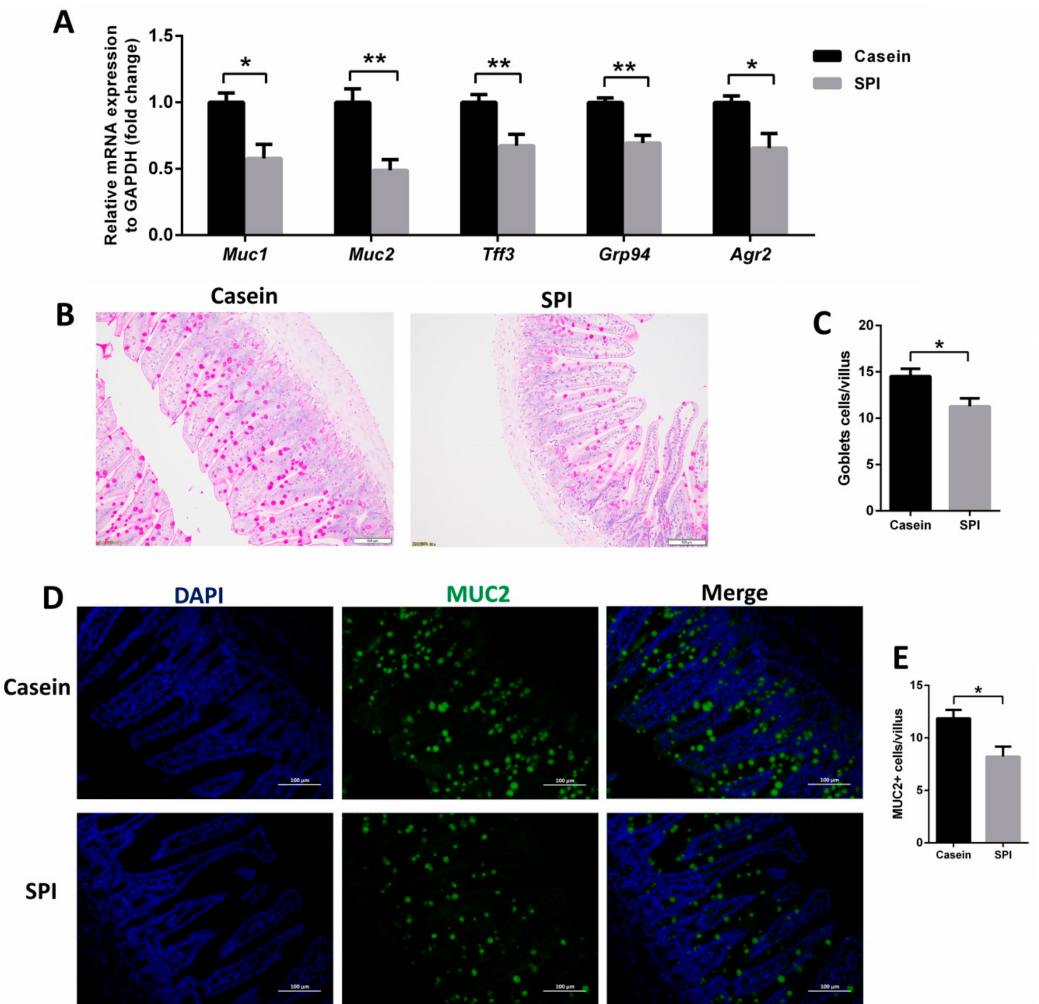
Figure 4. E ff ect of SPI on mucin production in mouse ileum tissue. ( A ) qRT-PCR analysis of Muc1 , Muc2 , T ff 3 , Grp94 , and Agr2 mRNA expression levels in mouse ileum tissue (normalized against Actb ( β -actin); n = 8). ( B , C ) Representative PAS-stained histomicrographs and corresponding quantification of goblets cell per villus in the ileum tissue ( n = 6). ( D,E ) Representative micrographs for MUC2 staining and corresponding quantification of MUC2 + goblet cells per villus in the ileum tissue ( n = 6). All data are presented as means ± SEM. * p < 0.05; ** p < 0.01. Statistical significance was